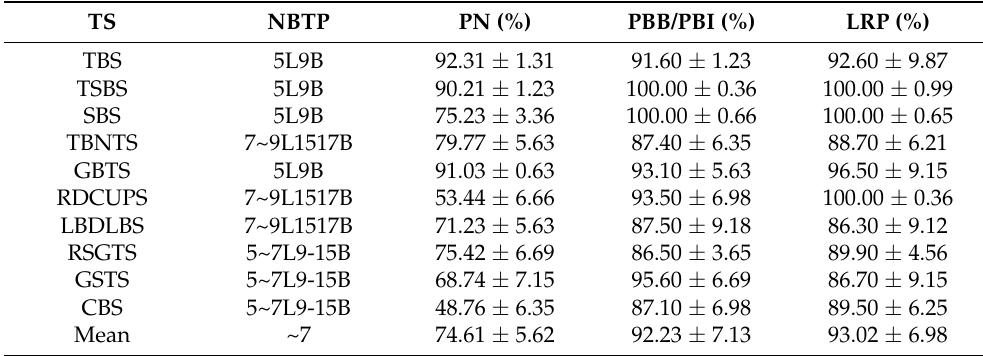
Table 3. Comparison of the branch plates of the ten kinds of regular-style potted